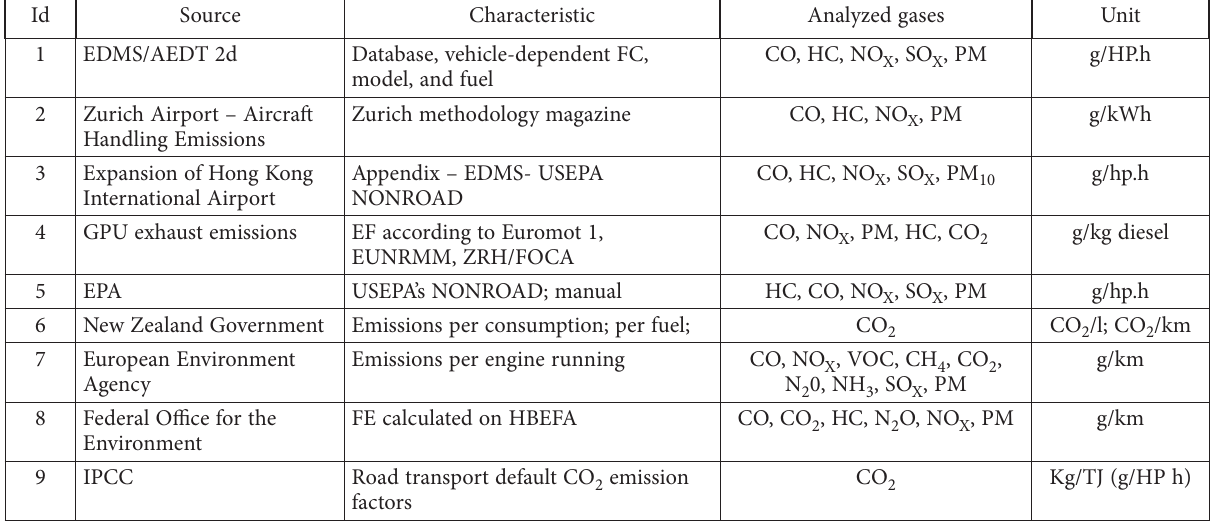
Table 2. Emission factors (source: authors)